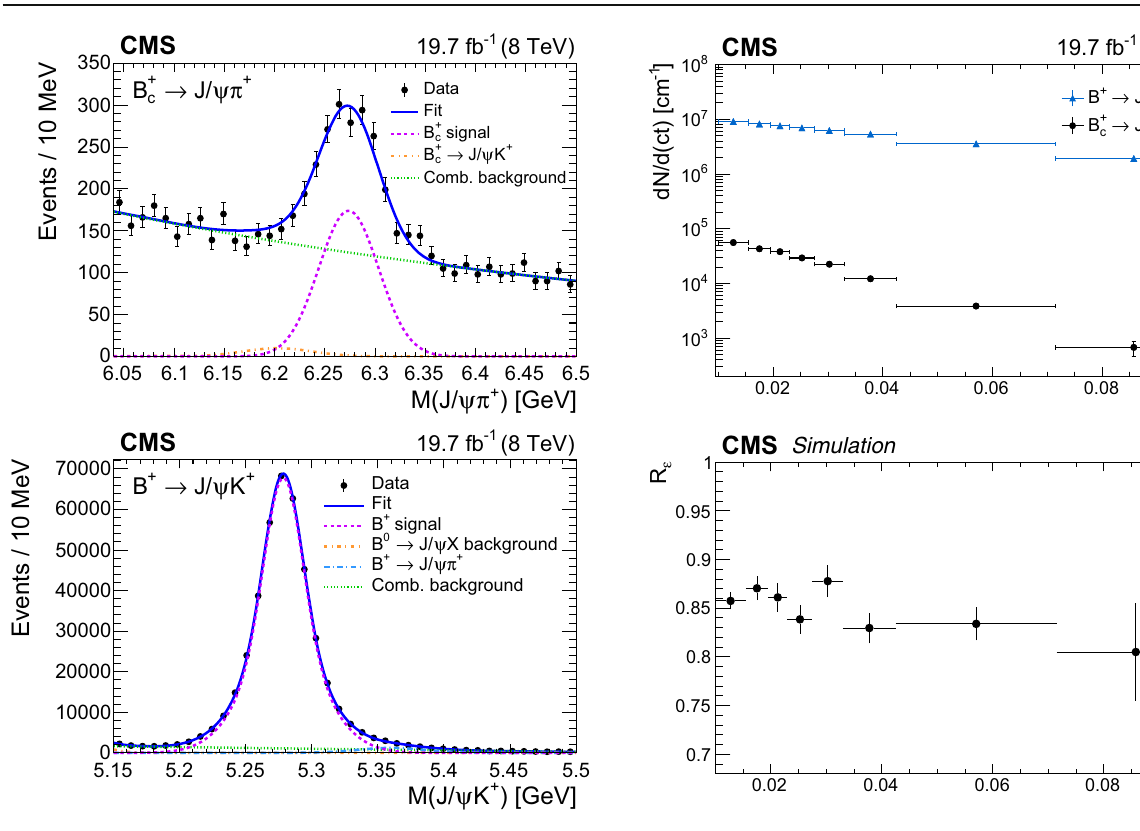
time, c τ = 162.3 ± 7.8 µ m, is extracted, where the uncer- B + c tainty is statistical only.